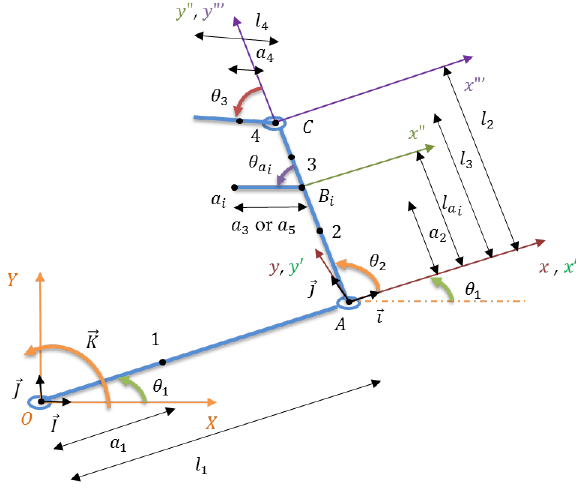
Figure 2. Dynamic modeling of the human hand.